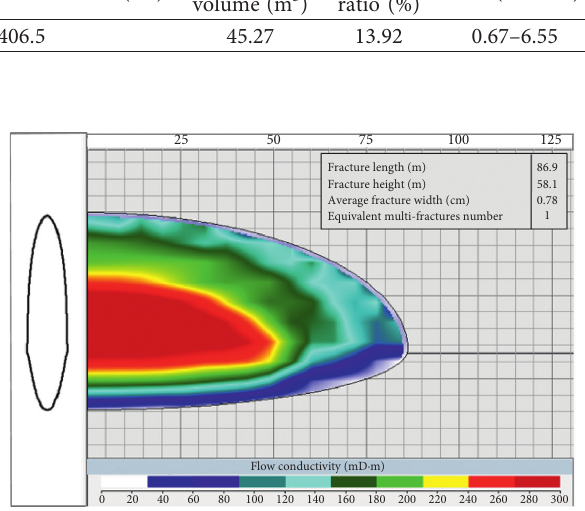
Figure 13: The simulated fracture